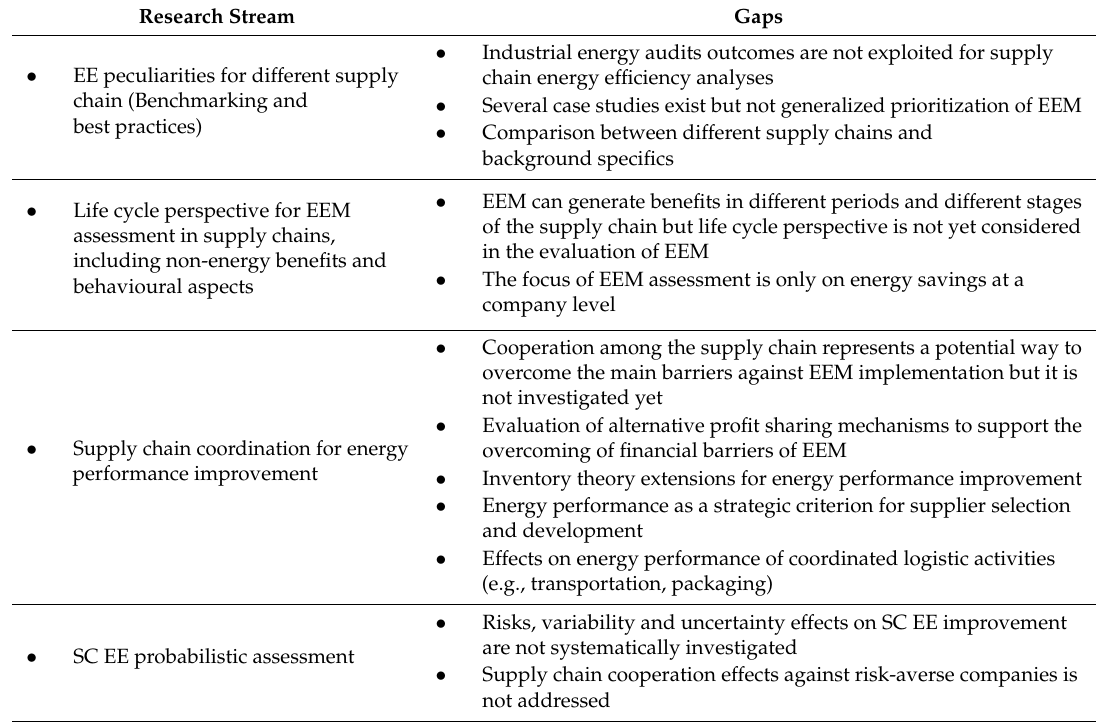
Table 3. Resume of gaps identified in current literature and potential future research